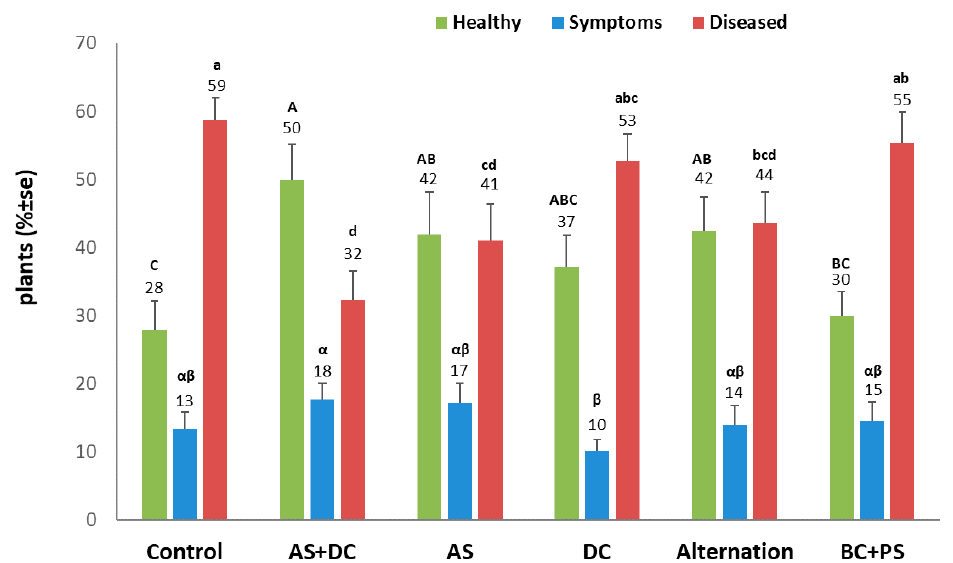
Figure 5. Wilt assessment (Amir, summer 2018). Values were determined 71 DAS (16 DAF). Symptoms—plants with dehydration symptoms appeared on the leaf whose cob was located in its lap. Diseased—plants in which the entire cob dried out. Upper error bars represent the standard error of the mean of 10 replications. Levels not connected by the same letter (A, B, C—for the healthy plants; a, b, c, d—for the diseased plants; and α , β —for the symptomatic plants) are significantly different ( p < 0.05, ANOVA).